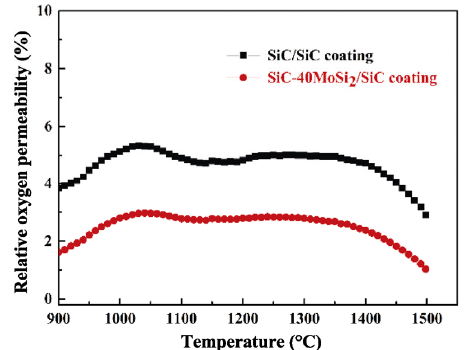
Fig. 6 Relative oxygen permeability curves of the SiC/SiC coating and the 40wt%MoSi 2 –SiC/SiC coating.